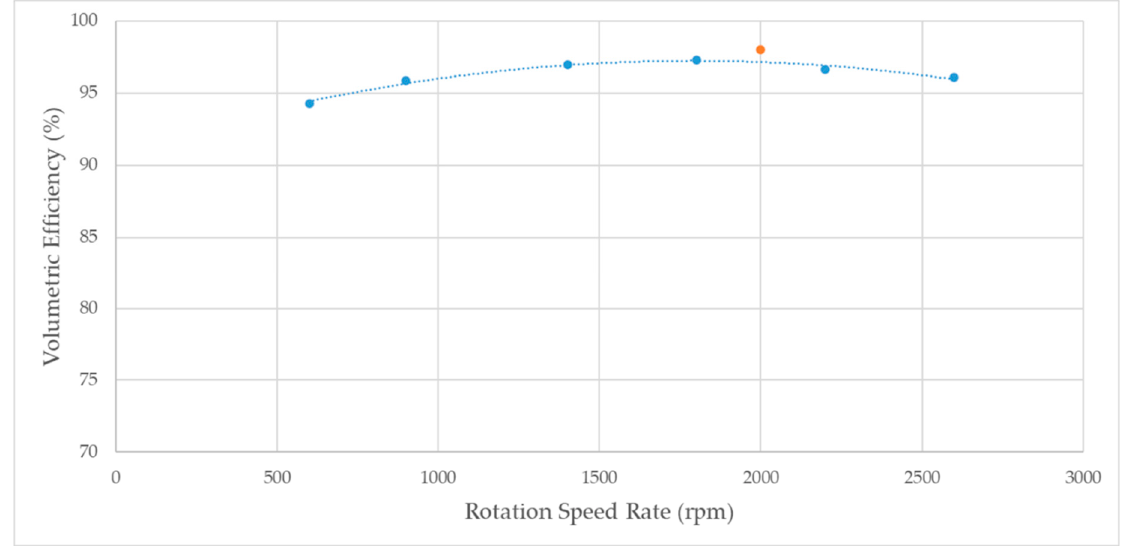
Figure 11. Experimental volumetric efficiency of the pump (blue) and CFD result in Case #2 (orange).